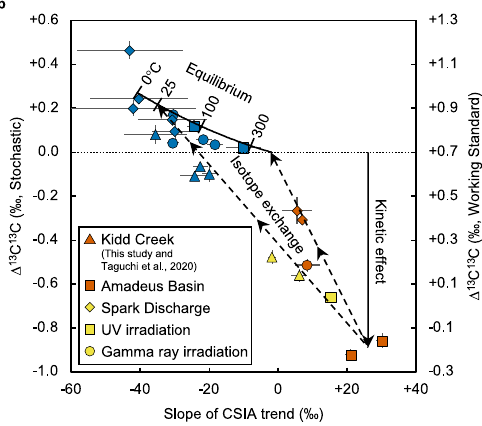
Fig. 2 | Δ 13 C 13 C vs. slope of compound-speci fi c isotopic analysis (CSIA) trend. The horizontal axis shows the slope of the relationship between δ 13 C and 1/n c (derived from Fig. 1b), which also assumed to be an intrinsic δ 13 C bias between the two positions of carbon ina molecule(seetext).The Δ 13 C 13 C scaleto the stochastic distributionwasestimatedbyassumingthattheC-Cbondsofbiologicalglucoseare under homogeneous isotopic equilibrium (see Methods). The error bars are the standard error of the mean. a The curved black line shows the predicted Δ 13 C 13 C value of ethane produced by C-C bond cleavage from an organic precursor (denoted as ‘ P ’ ) at each temperature, considering the combinatorial effect (see Methods). The CSIA slope at each temperature is also calculated using the same